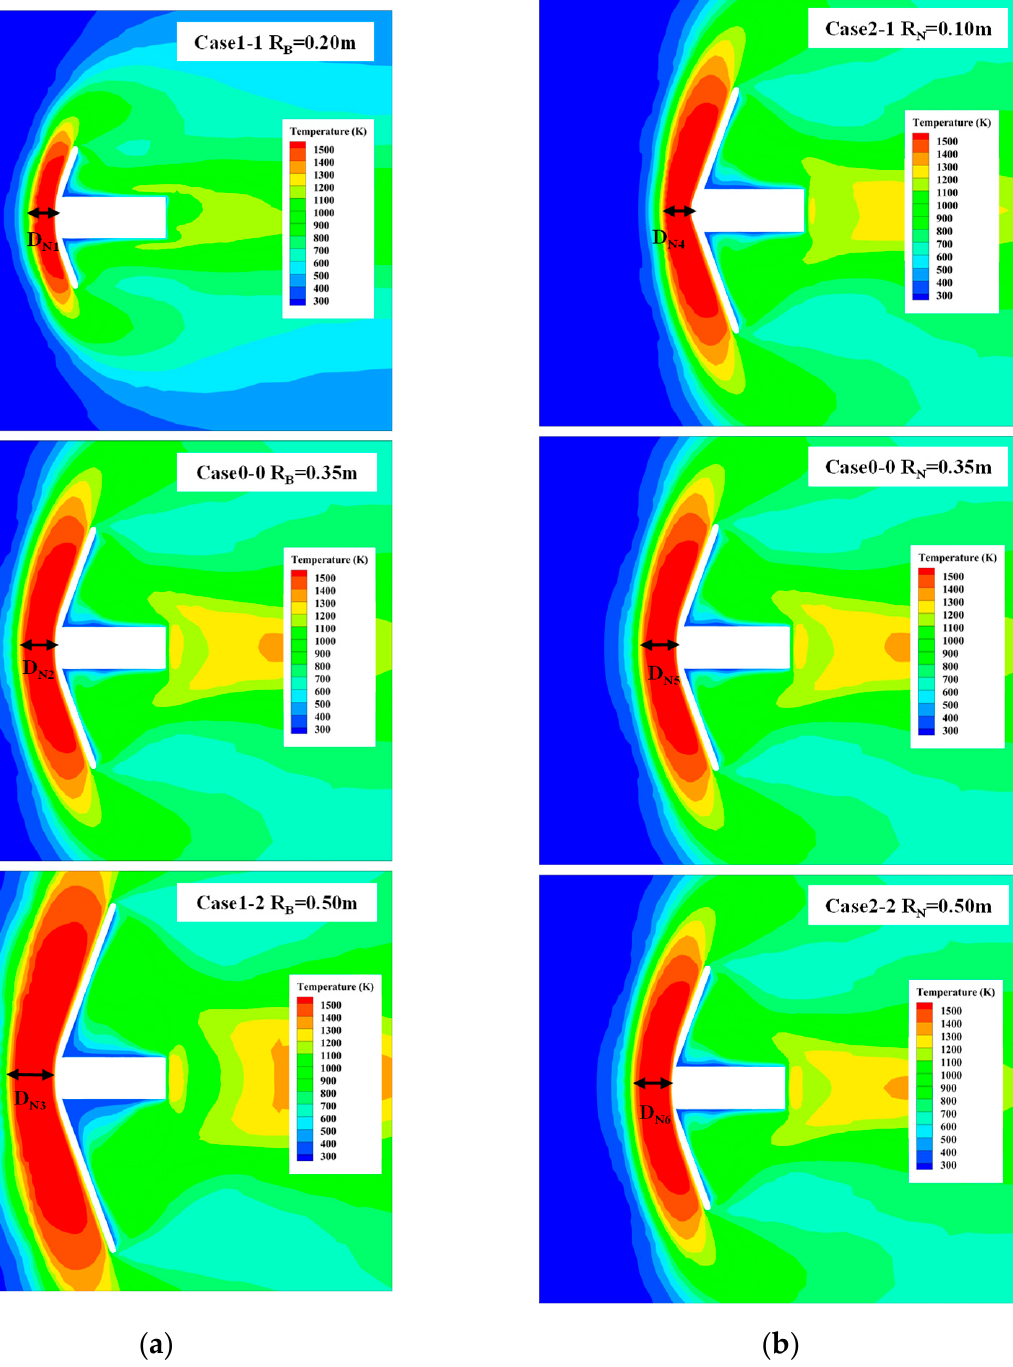
Figure 10. Temperature contours of case 0-0, case 1-1 to case 2-2: ( a ) R B is changed; ( b ) R N is changed. The heat flux distribution with different R B and R N are shown in Figure 11; when only R B and R N change, the heat flux of the shoulder Q R is always larger than that of the stagnation point Q O . Q O and Q R decrease when R B increases. When R N changes from large to small, Q O and Q R increase respectively; however, the difference value between Q